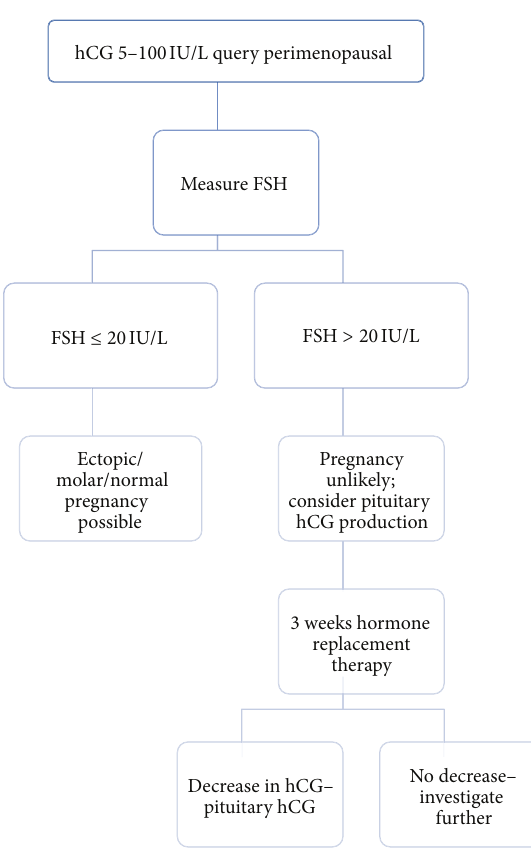
Figure 1: Algorithm for interpreting low serum hCG results in perimenopausal women to exclude pituitary hCG